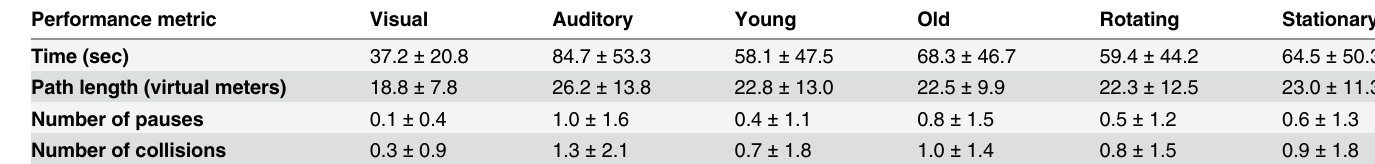
Table 1. Average values (mean ± SD) per performance metric.